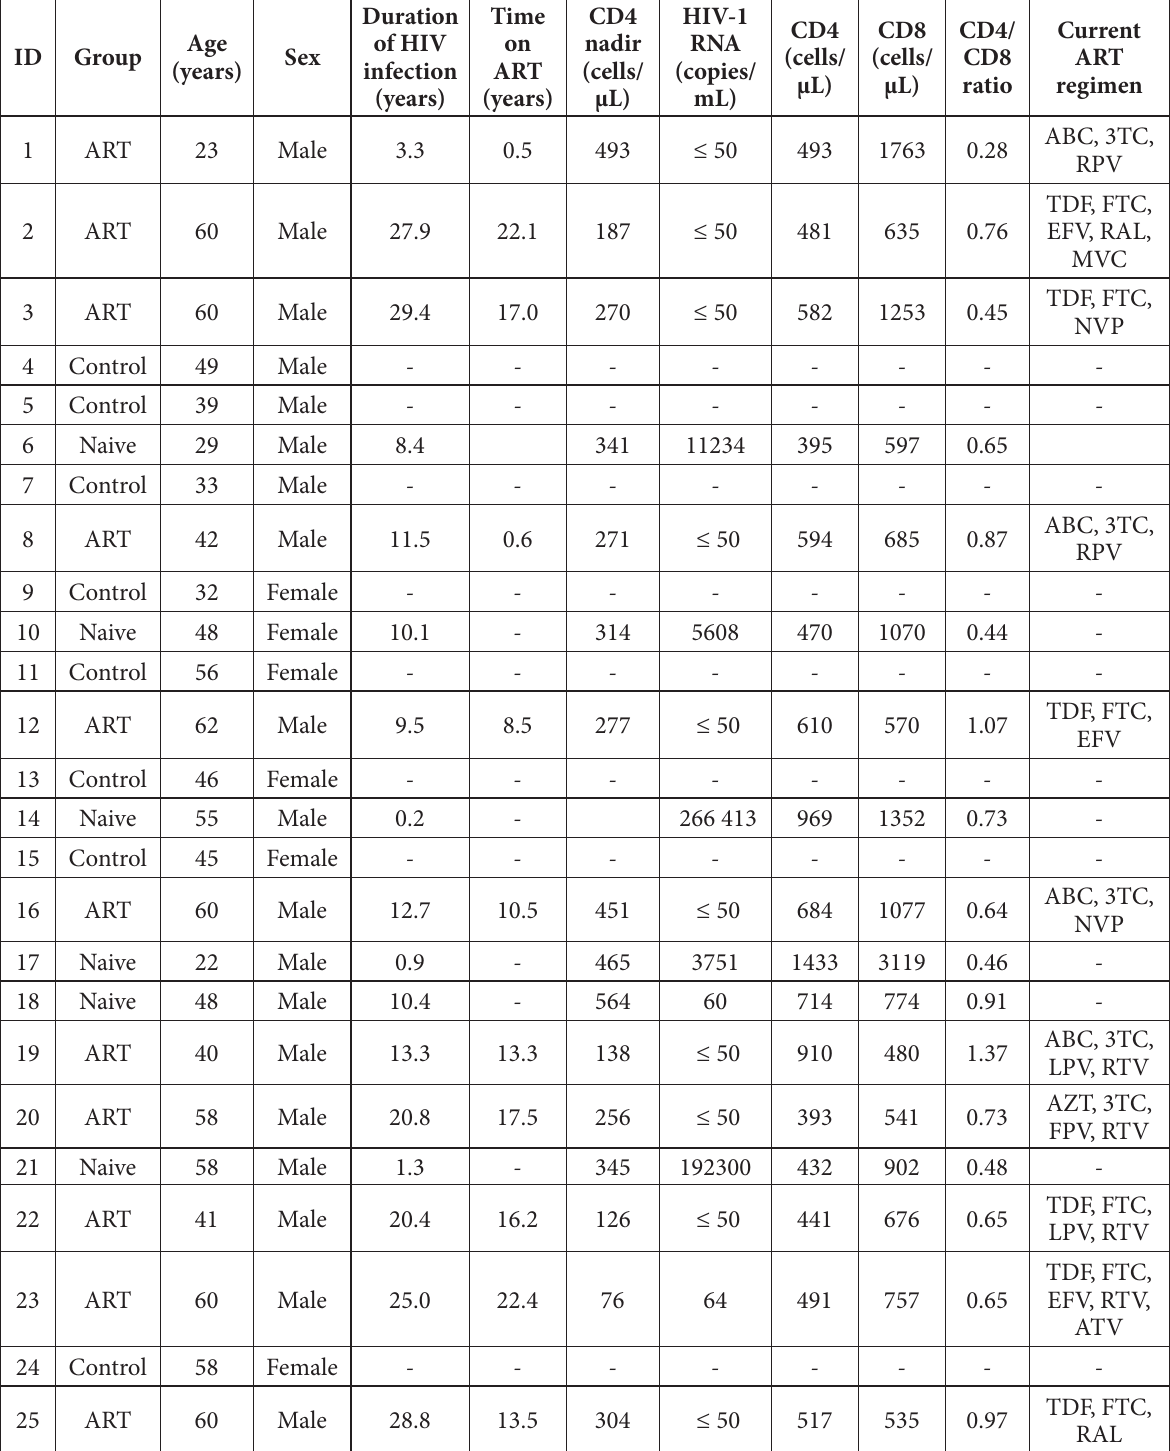
Table 1: Characteristics of participants enrolled in the study